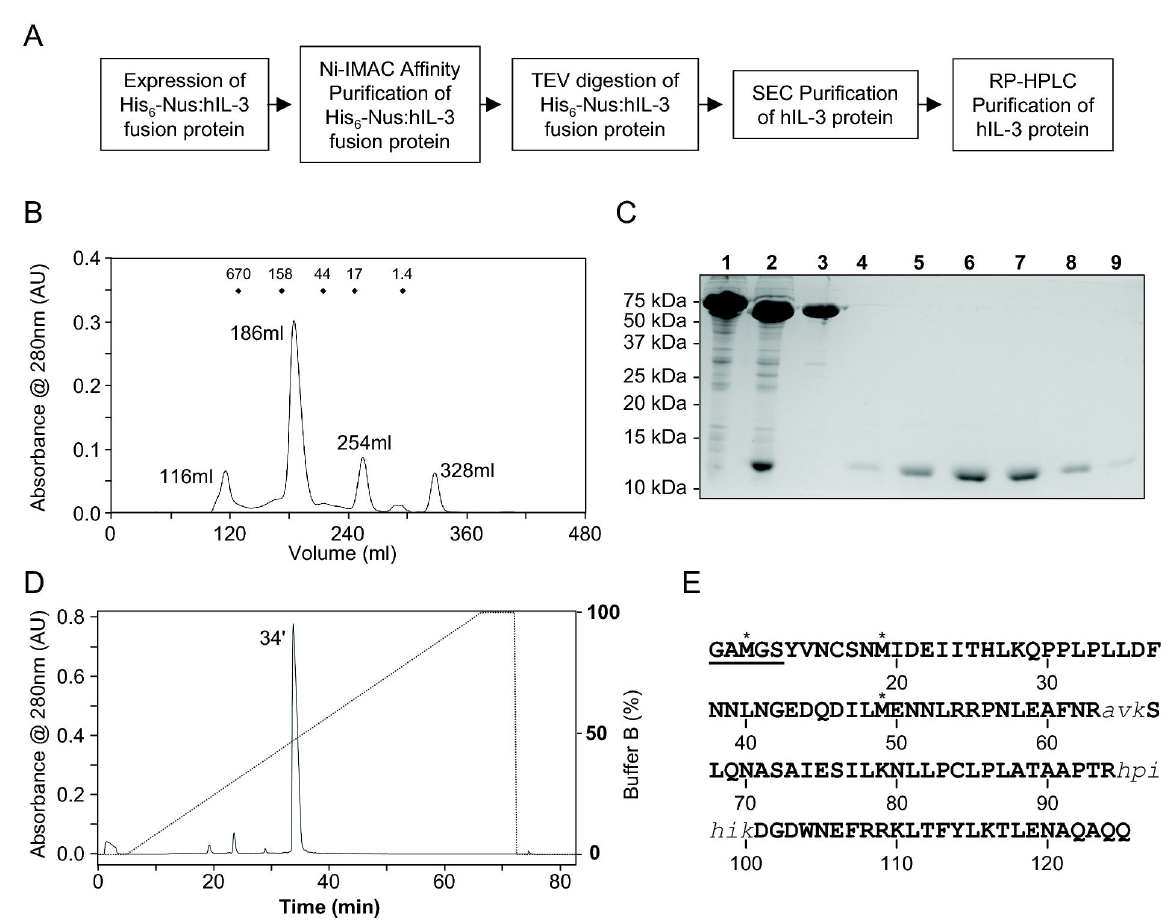
Figure 2. Purification of the hIL-3(13-125; W13Y) analog. A) Workflow diagram illustrating the purification protocol for hIL-3(13-125;